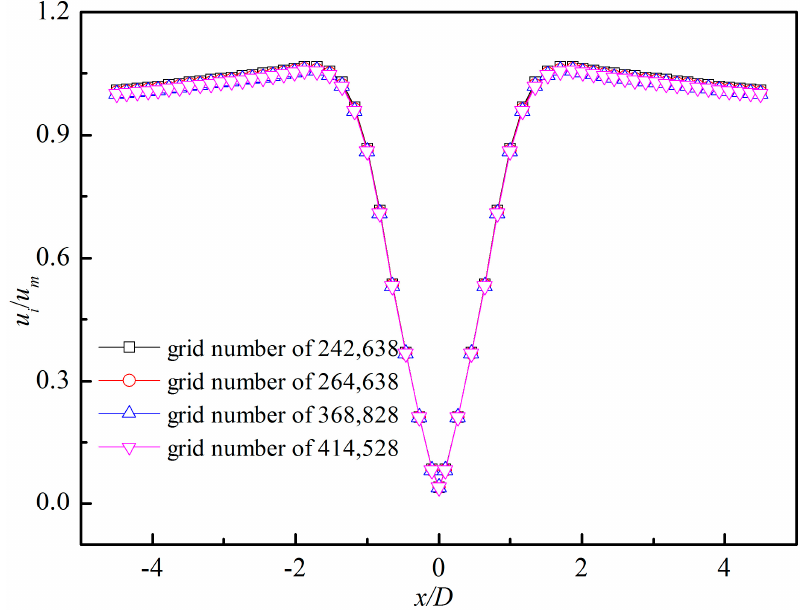
Figure 3. Fluid velocity distribution on the axis of the xz plane, as determined using computational fluid dynamics (CFD), with a constant inlet velocity of u m = 1.25 m/s.